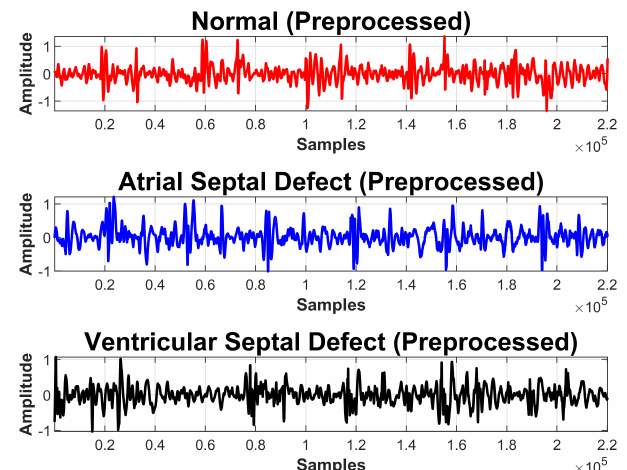
Figure 5. IMFs extracted from the PCG signal of a VSD subject.